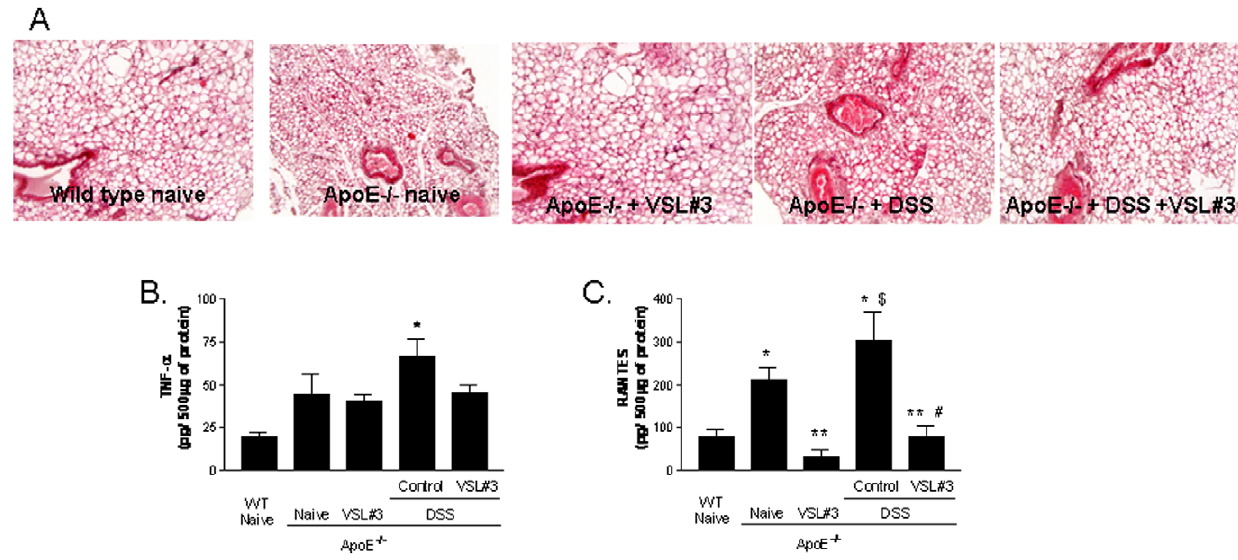
Figure 3. Effect of VSL # 3 administration in mesenteric fat inflammation. A) Histopathology analysis of mesenteric fat isolated from experimental groups, original magnification 20 6 , H&E staining. Adipose tissue concentration of ( B ) TNF a and ( C ) RANTES. Data are mean 6 SE of n=5 mice per group. * p , 0.05 ApoE 2 / 2 experimental group versus naive wild type group; ** p , 0.05 ApoE 2 / 2 naı¨ve group versus ApoE 2 / 2 plus VSL # 3 group; $ p , 0.05 ApoE 2 / 2 naive group versus ApoE 2 / 2 plus DSS group; # p , 0.05 ApoE 2 / 2 plus DSS group versus ApoE 2 / 2 plus DSS and VSL # 3 group.